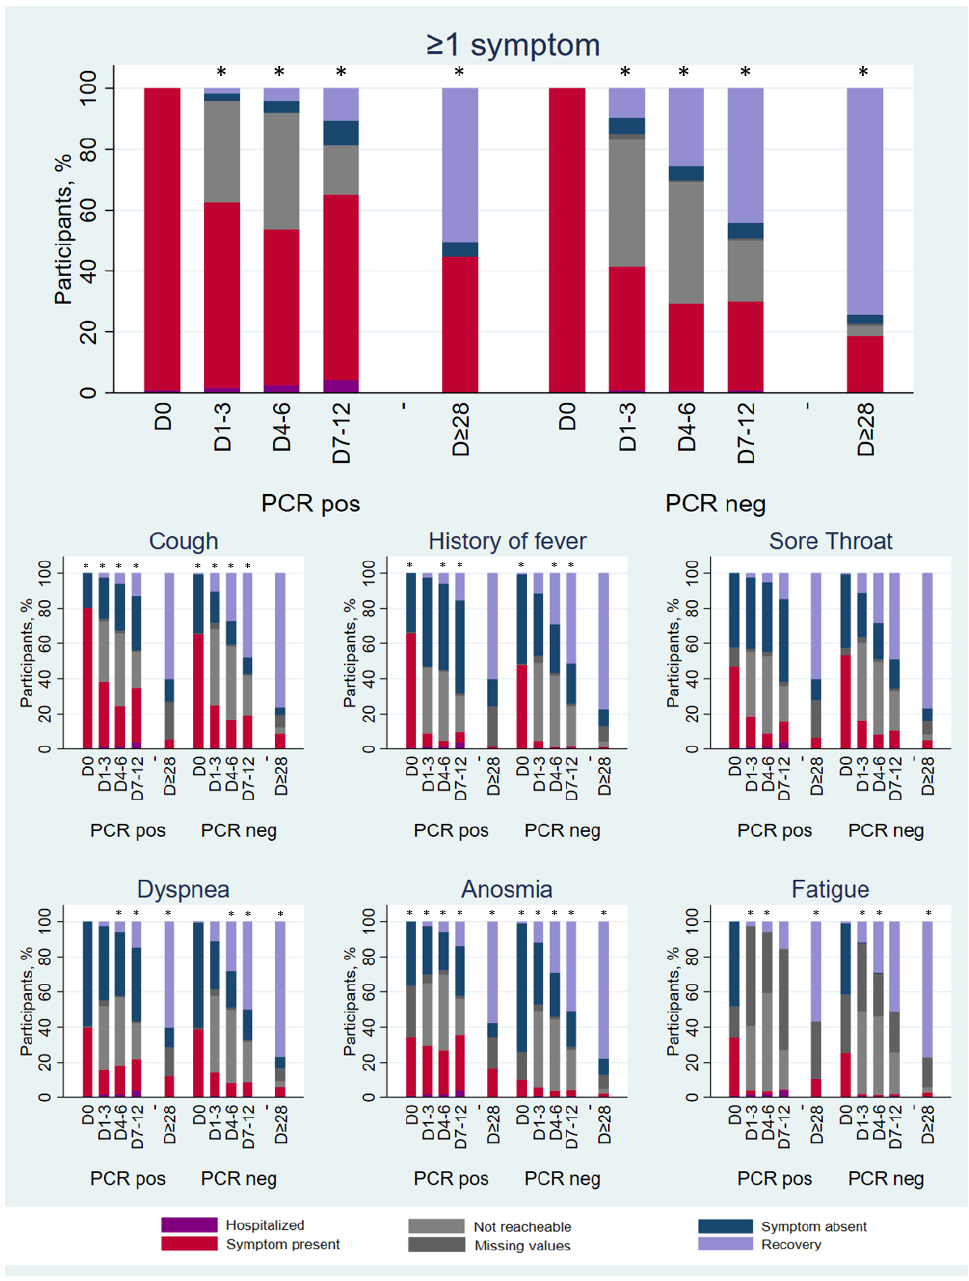
Figure 2. Proportion of patients reporting of specific symptoms over time by SARS-CoV-2 RT-PCR test results. * = p < 0.05; p -value of chi-square test comparing symptomatic versus asymptomatic or